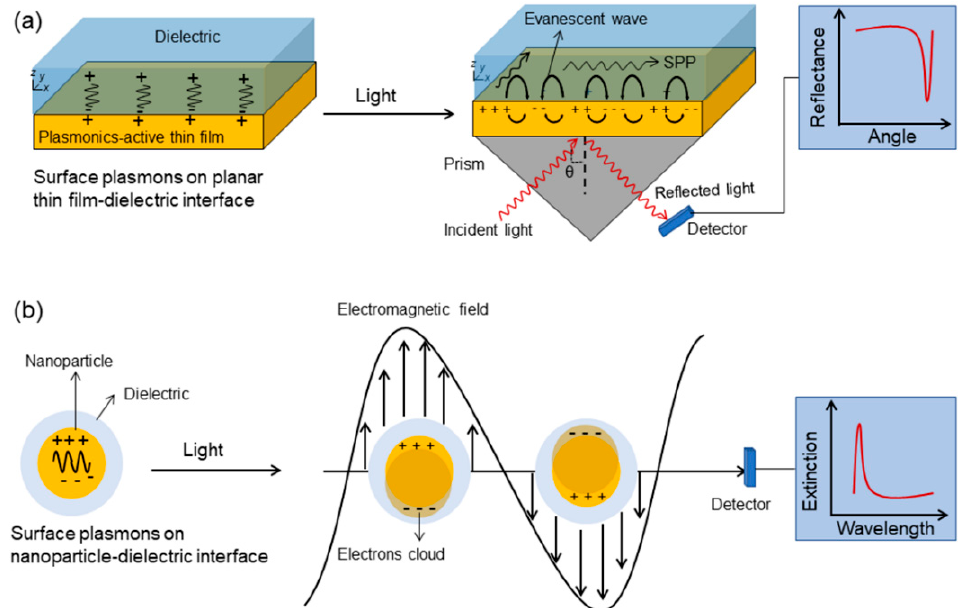
Figure 1. Schematic diagrams illustrating the excitation of surface plasmons from ( a ) thin film using prism as a coupling device, generating propagating surface plasmon or surface plasmon polariton (SPP), and ( b ) nanoparticle, generating a localized surface plasmon resonance (LSPR). The typical spectra that can be obtained after the surface plasmon excitation are shown on the right.